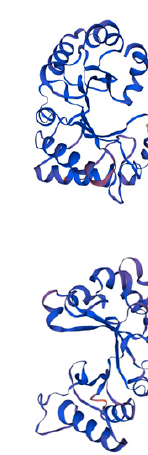
Figure 5. Phylogenetic tree of the CHI III. Multiple alignments of the sequences of CHI III and other selected plant chitinase were performed using MEGA 6. The three red point represents the chitinase of three mangrove plants in the fi gure.